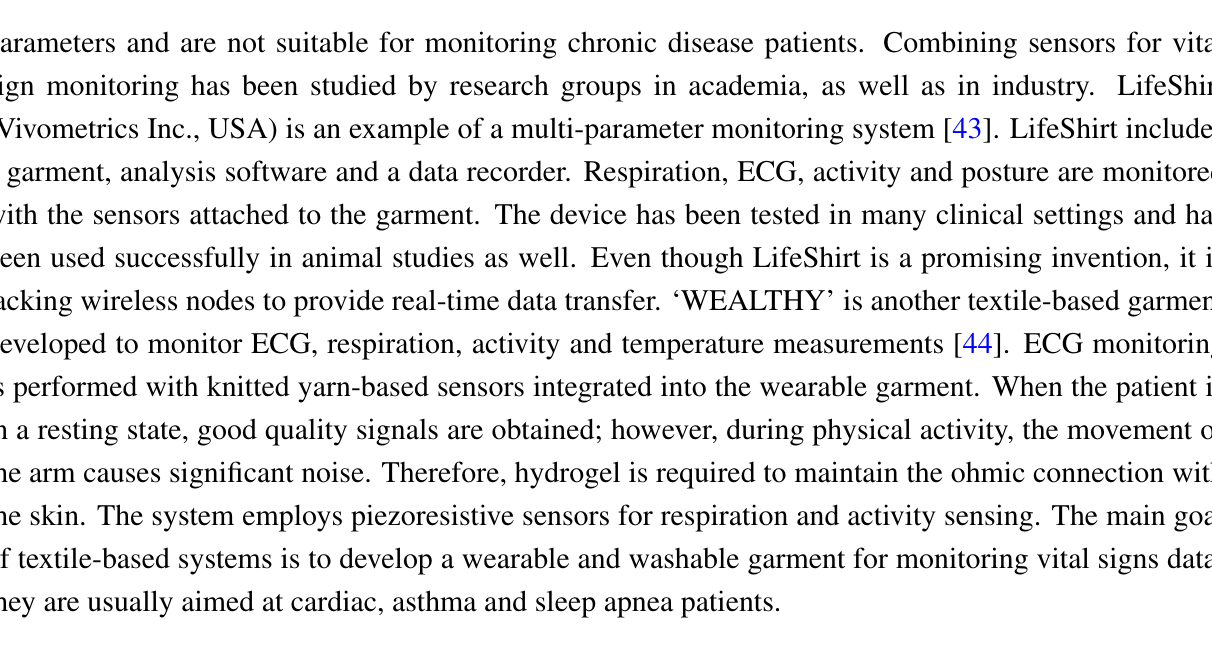
Figure 5. AMON wrist module